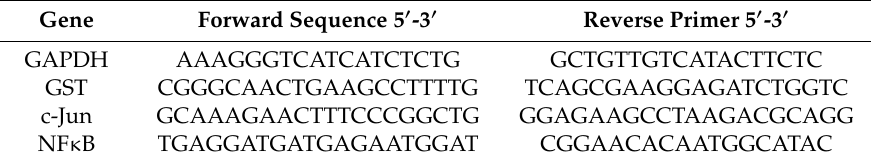
Table 1. Primers used for RT–PCR amplification of specific genes on Calu-3 cells at ALI. Gene Forward Sequence 5 (cid:48) -3